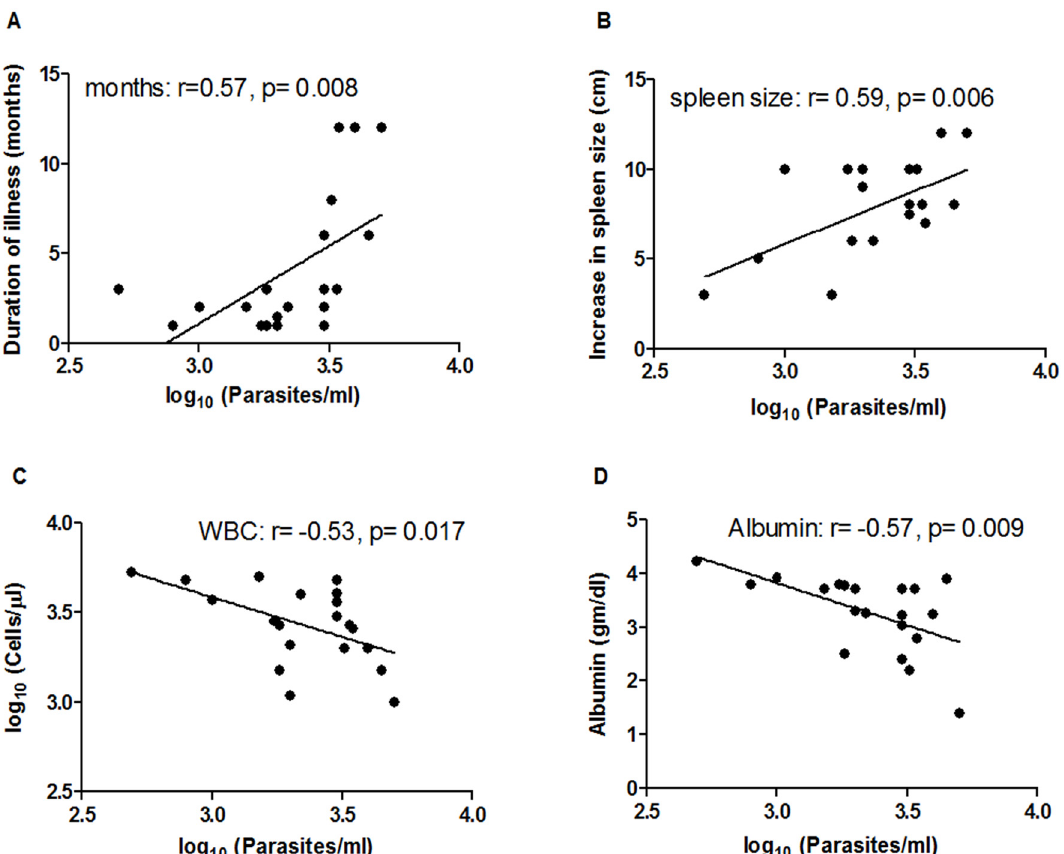
Fig 2. Correlation of parasite load with different clinical and hematological parameters of VL patients (n = 20). Duration of illness (months, panel A), increase in spleen size (cm, panel B), white blood cell counts (cells/ μ l, panel C) and albumin levels (gm/dl, panel D) of VL patients were obtained from the hospital. Parasite loads (Parasites/ml) were determined by real-time PCR. Correlation was calculated using the Spearman/Pearson correlation test. Diagonal lines represent linear regression.